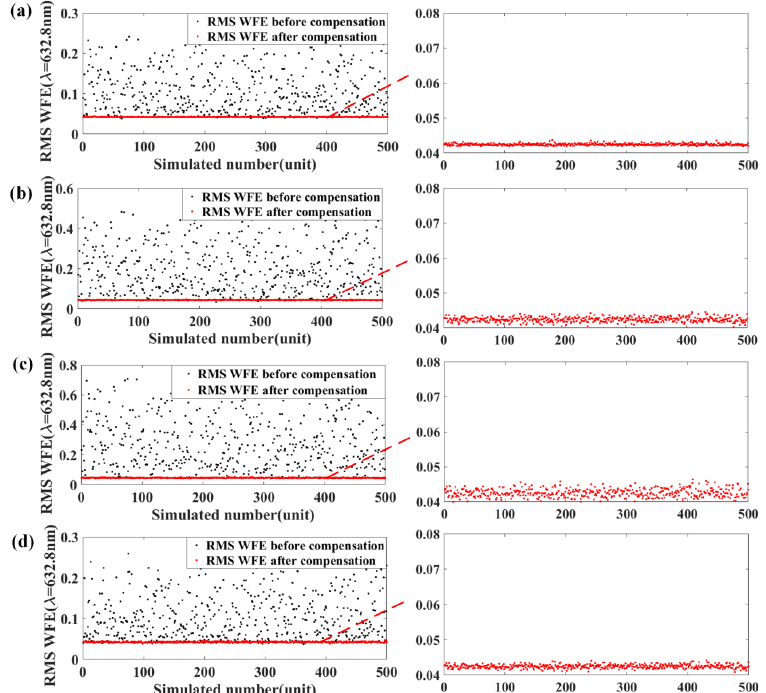
Figure 6. Average RMS WFE before and after compensation of the optical system based on SMCM: ( a ) Case 1, ( b ) Case 2, ( c ) Case 3, and ( d ) Case 4. It could be noted that the black and red spots represent the average RMS WFE before and after compensation, respectively.